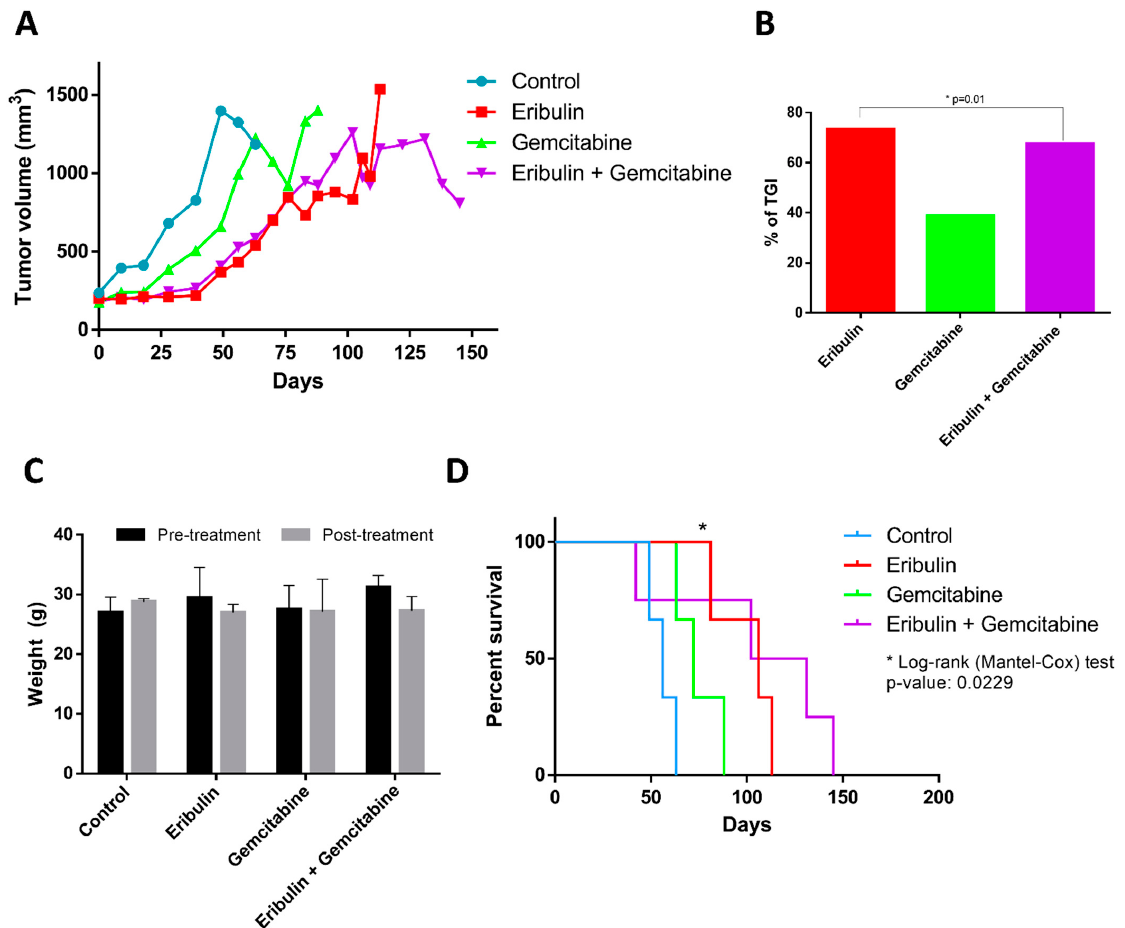
Figure 5. Effect of the combination of eribulin and gemcitabine in vivo in the PDX model LMS-IBiS- 010. ( A ) Tumour volume, expressed in mm 3 , of mice subjected to each of the treatments: control (blue; n = 3), eribulin in monotherapy (red; n = 4), gemcitabine in monotherapy (green; n = 4) and eribulin + gemcitabine (purple; n = 4). Mice were sacrificed when they reached the volume of 1500 mm 3 . ( B ) Percentage inhibition of tumour growth with respect to the control group calculated on day 14 of treatment. Wilcoxon test for paired samples: * p < 0.05. ( C ) Weight, expressed in grams, of each experimental group before and after treatment with each of the drugs. ( D ) Kaplan–Meier curve representing the survival probability of the different treatment groups. Log-rank test (Cox Mantel): * p < 0.05.